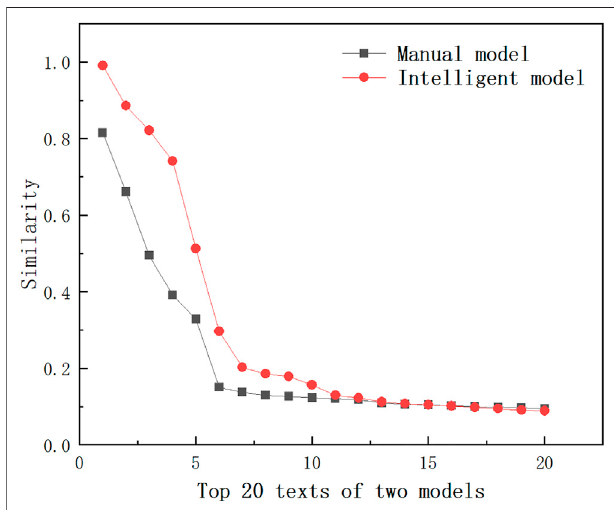
FIGURE 6 | Comparison of similarity between different models in the same text.